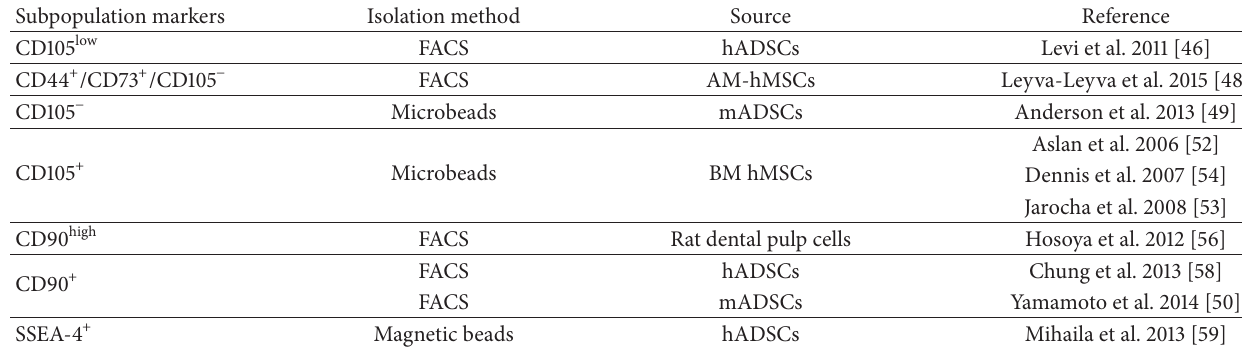
Table 1: MSC subpopulations with enhanced osteogenic